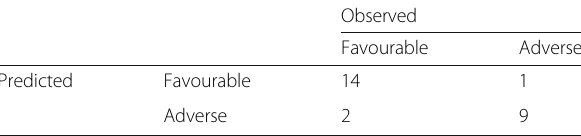
Table 4 Confusion matrix for the support vector machine with linear kernel prediction on the testing